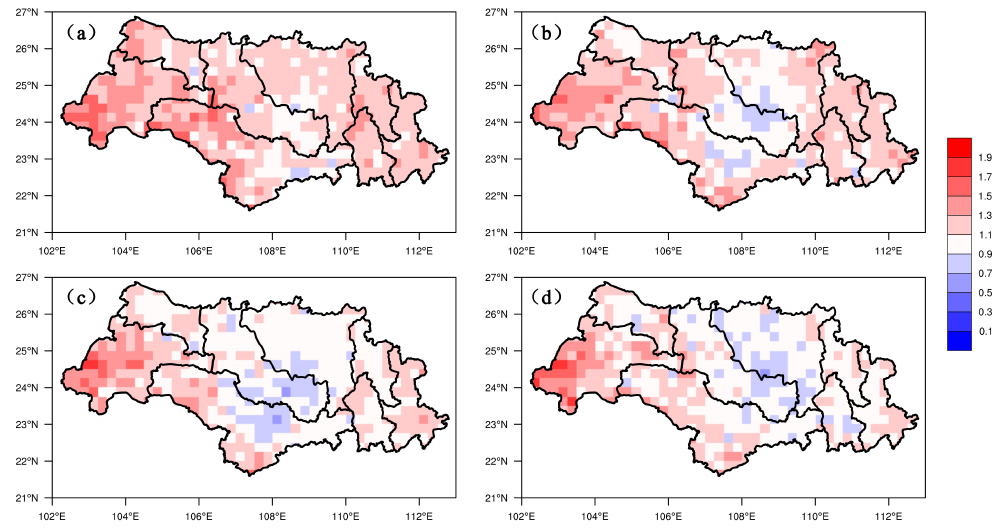
Figure 9. Study region maps showing the spatial distribution of Bias ( ≥ 0.1 mm/day) in the Xijiang Basin. ( a ) 24 h lead time; ( b ) 48 h lead time; ( c ) 72 h lead time; ( d ) 96 h lead time.